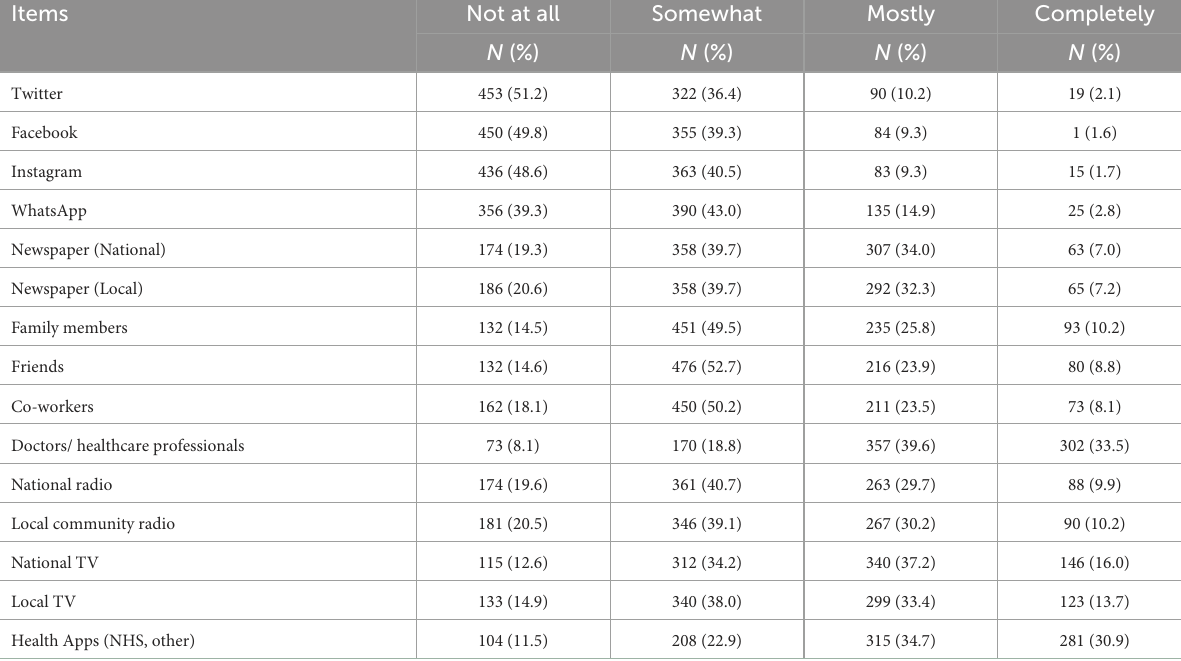
TABLE 5 Trustworthiness of sources to provide accurate information about COVID-19.